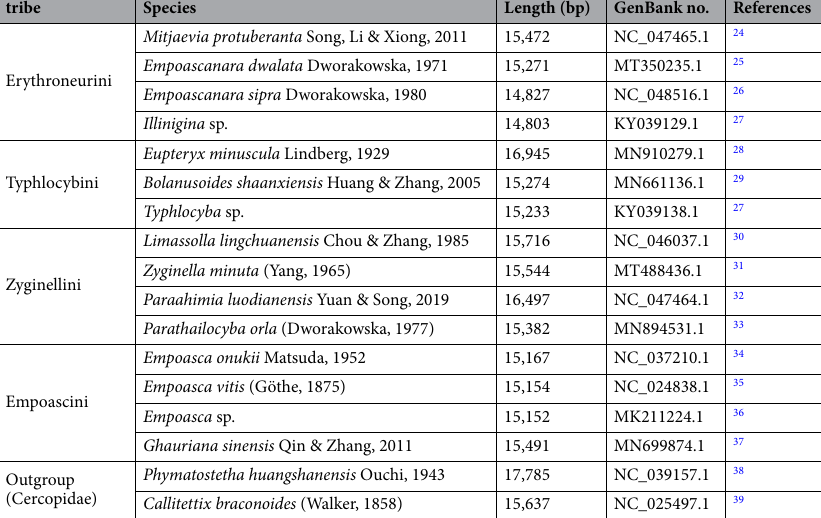
tribe Species Length (bp) GenBank no. References